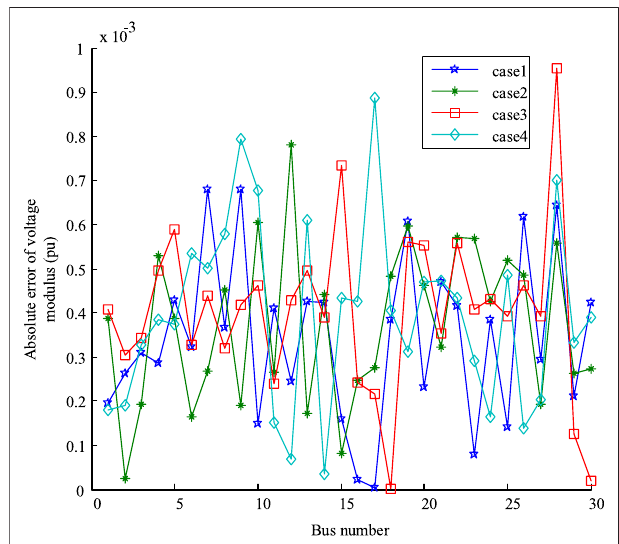
FIGURE 6 | The absolute error of the voltage amplitude of each method under Laplace measurement noise.